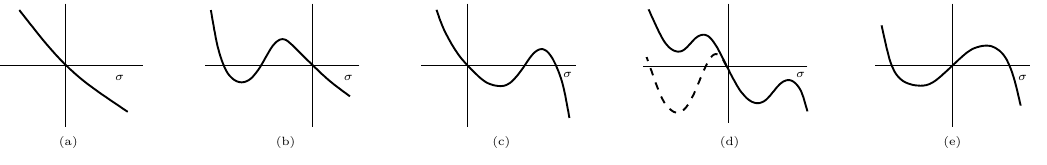
Figure 30 . Effective potential for Case III: A < 0 , A + a < 0